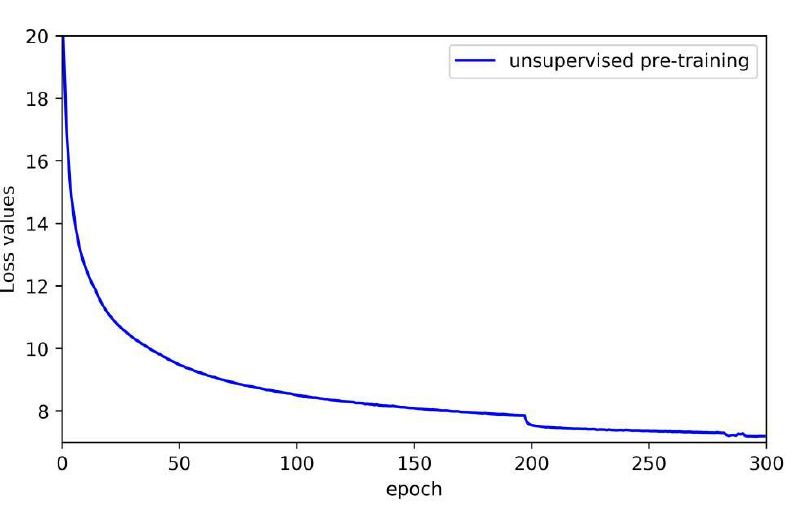
Figure 6. Unsupervised pre-training model training loss.